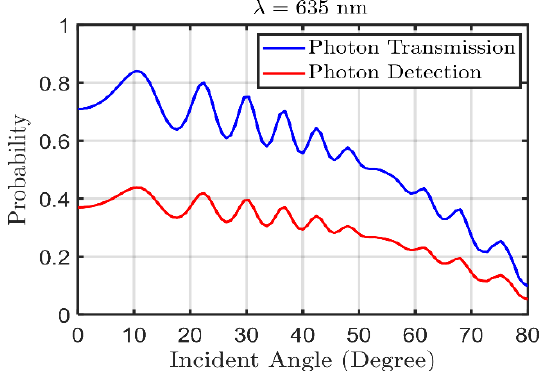
Figure 6. Photon transmission through the isolation and passivation stack and PDP of a pin-photo- Photon transmission through the isolation and passivation stack and PDP of diode CMOS SPAD as a function of the light incidence angle. a pin-photodiode CMOS SPAD as a function of the light incidence